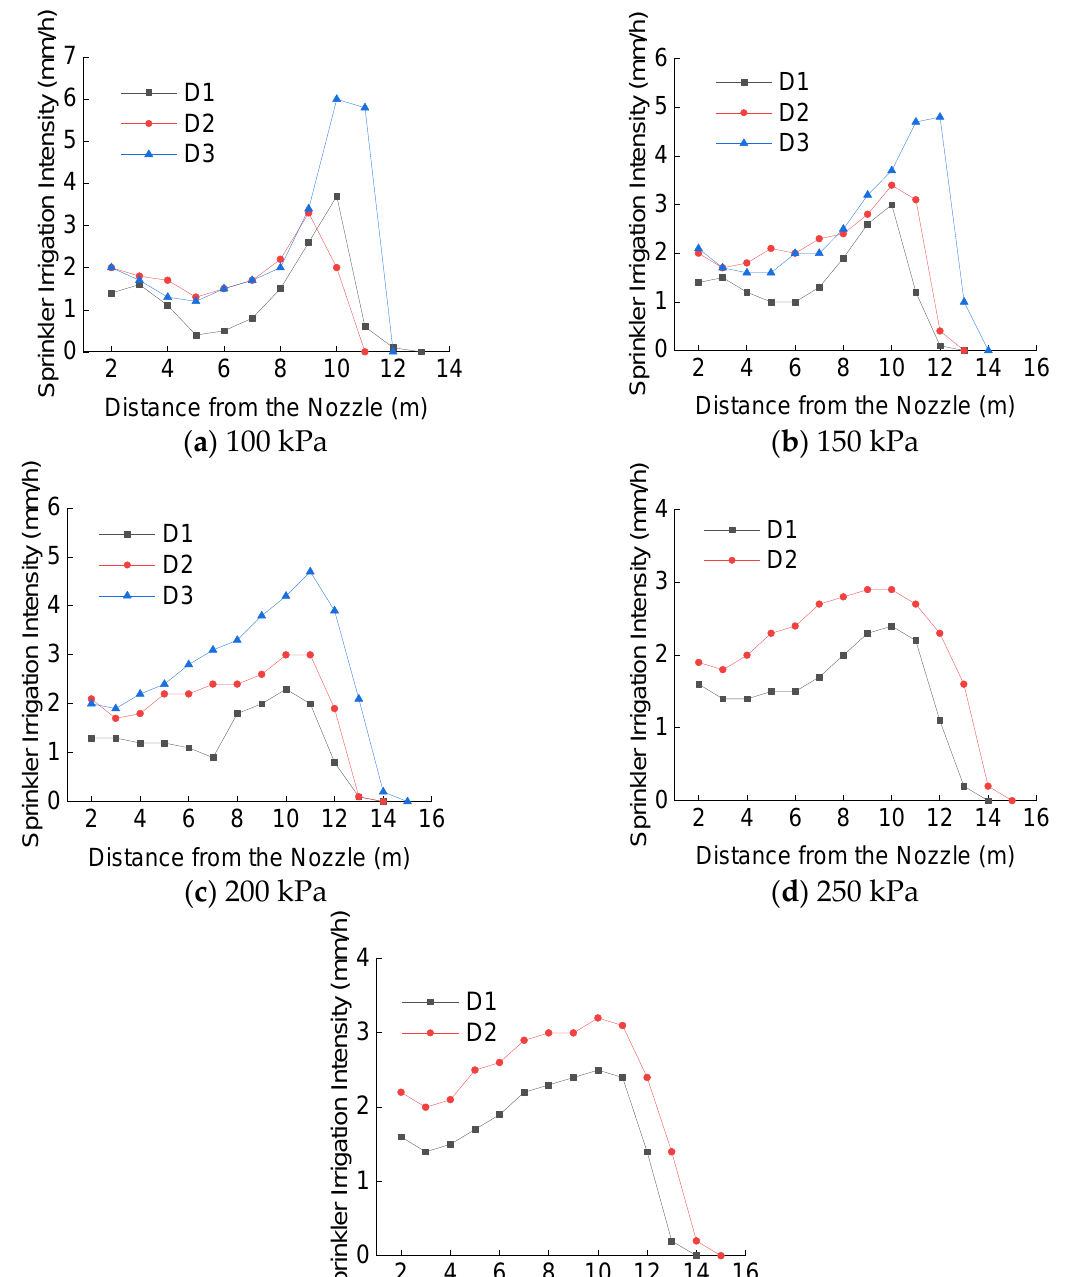
Figure 8. Radial water distribution of diamond nozzles with different outlet diameters under different working pressure levels. (D1, D2, and D3 refer to the diamond nozzles with aspect ratios of 1.54, 1.32, and 1.11, respectively).